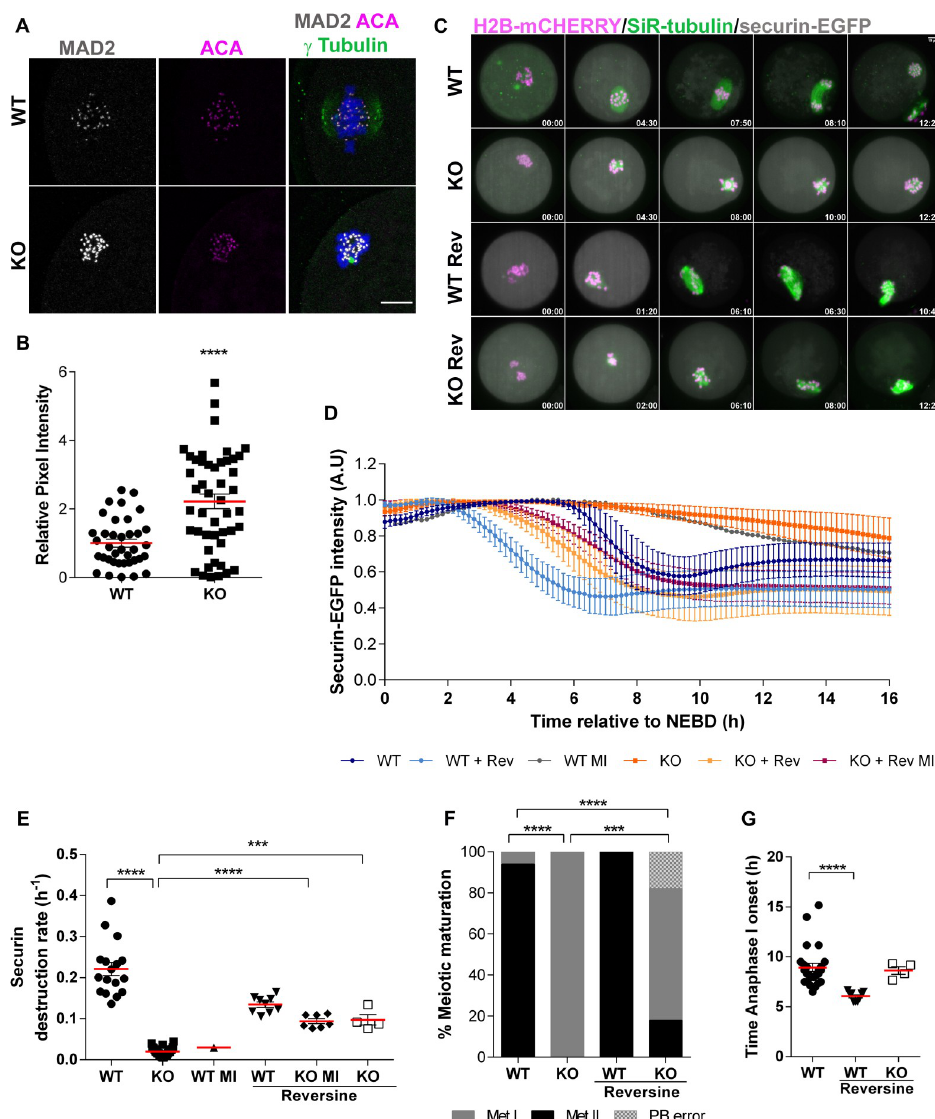
Fig 7. Aurka KO oocyte arrest is SAC independent. (A) Representative confocal images of oocytes from WT and Aurka KO females at Metaphase I immunostained with antibodies to detect centromeres (anti-centromeric antigen (ACA) (magenta)), MAD2 (gray) and chromosomes (DAPI (blue)). (B) Quantification of MAD2 intensity at kinetochores in (A) (Unpaired Students t-Test, two-tailed, ���� p < 0.0001; number of oocytes, WT: 37, A KO: 47). Scale bars: 10 μ m . (C) Live light-sheet imaging of oocytes expressing securin-EGFP (grey), H2B-mCherry (magenta, chromosomes) and stained with SiR-tubulin (green, microtubules) +/- 1 μ M reversine (Rev) treatment. Maximum intensity z-projection images are shown. Time relative to NEBD. Scale bar = 10 μ m. (D-G) Data from (C) was used for analysis. Number of oocytes, WT: 18, KO: 24, WT + reversine: 9, KO + reversine: 11. (D) Normalized intensities of cytoplasmic securin-EGFP signals. For normalization, maximum securin-EGFP signal in each oocyte was set to 1. Average +/- SD are shown. (E) Rate of securin-EGFP destruction (h -1 ) (Mann Whitney Test, �� p < 0.001, ���� p < 0.0001. (F) Proportion of WT and KO oocytes +/- 1 μ M reversine that reached different phases of meiosis (Met I– metaphase I, Met II–metaphase II, PB error–polar body extrusion retraction) after 16 h of time-lapse imaging (Likelihood Test, ��� p < 0.001, ���� p < 0.0001). (G) Anaphase I onset (hours relative to NEBD), which was defined as the first time point when segregation of chromosomes was detected (Mann Whitney Test, ���� p < 0.0001).